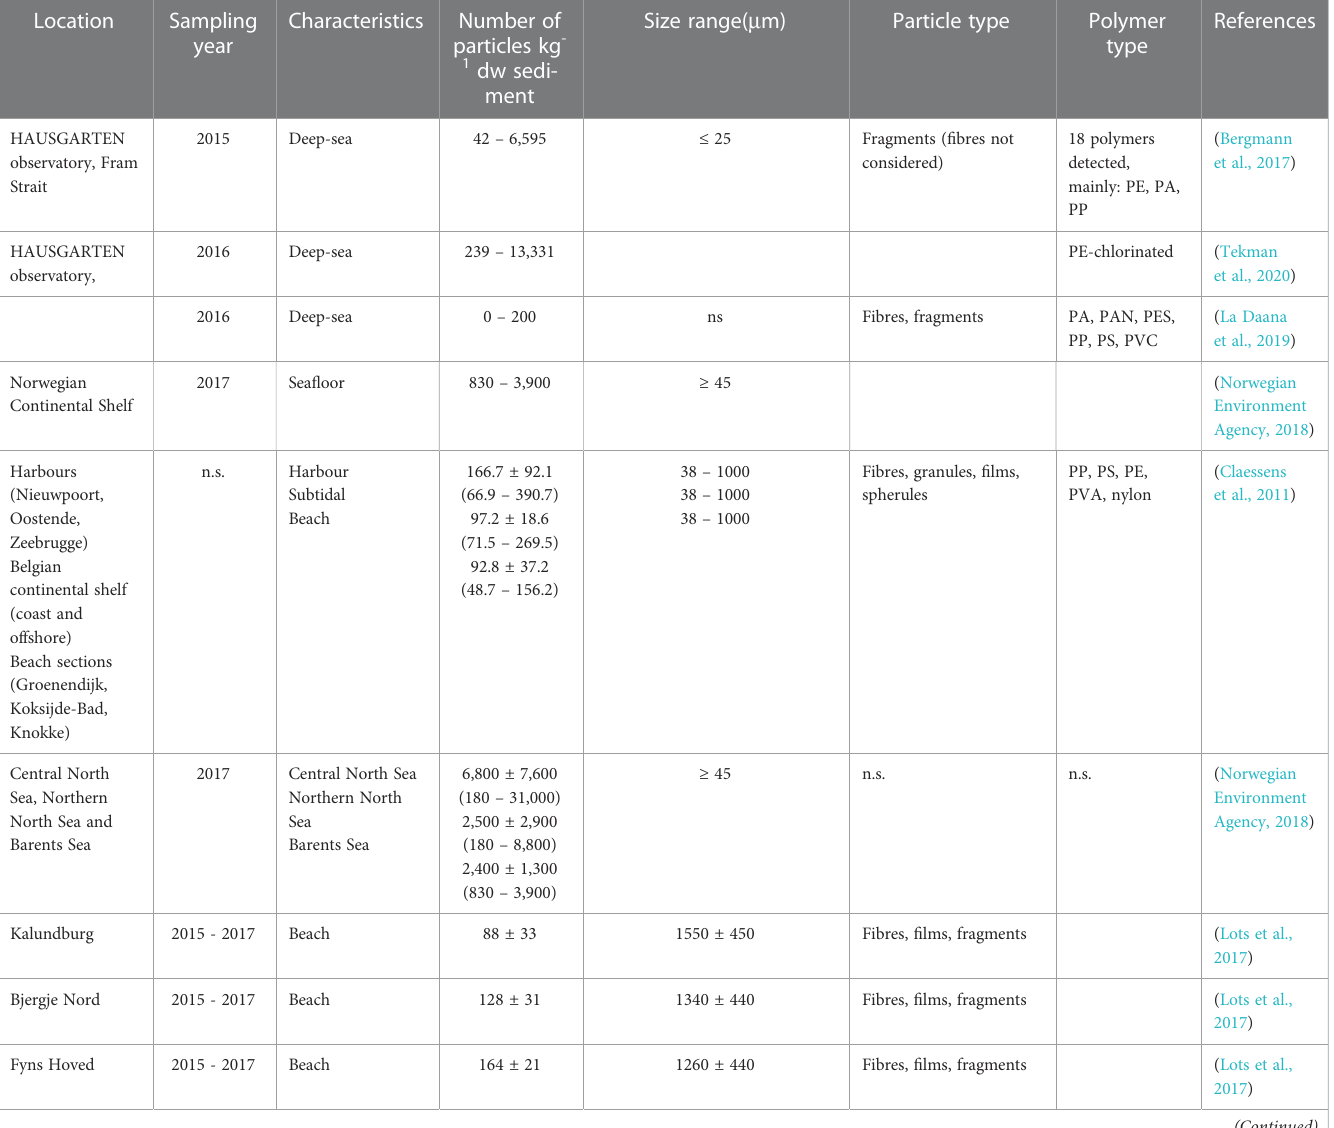
TABLE 1 Number of particles kg -1 dry weight (d.w.) sediment reported in the literature by OSPAR region (mean ± SD, range in brackets).